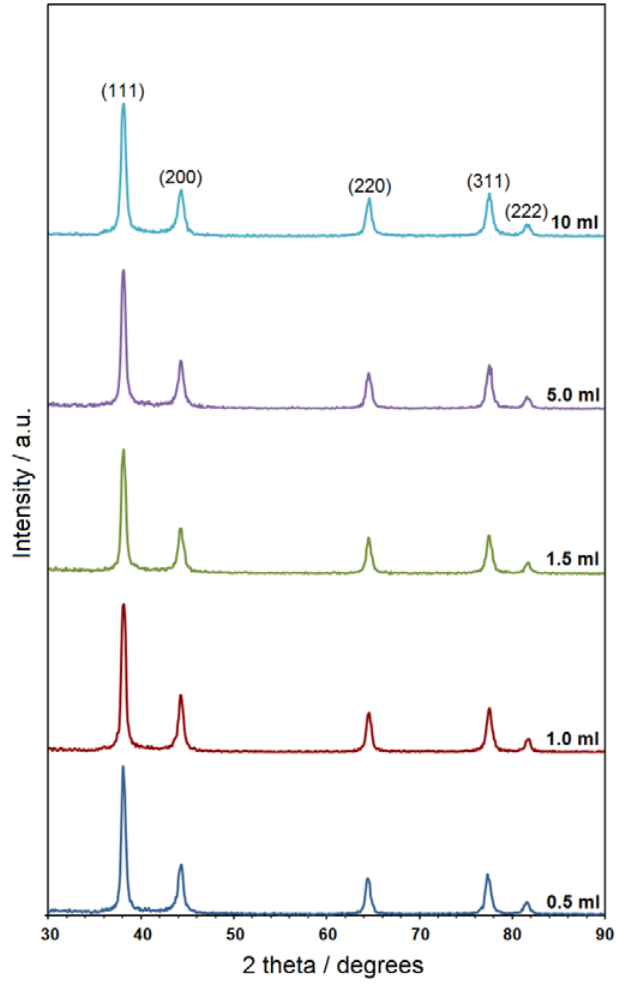
Figure 3. The PXRD patterns of Ag-NPs prepared at different volumes of